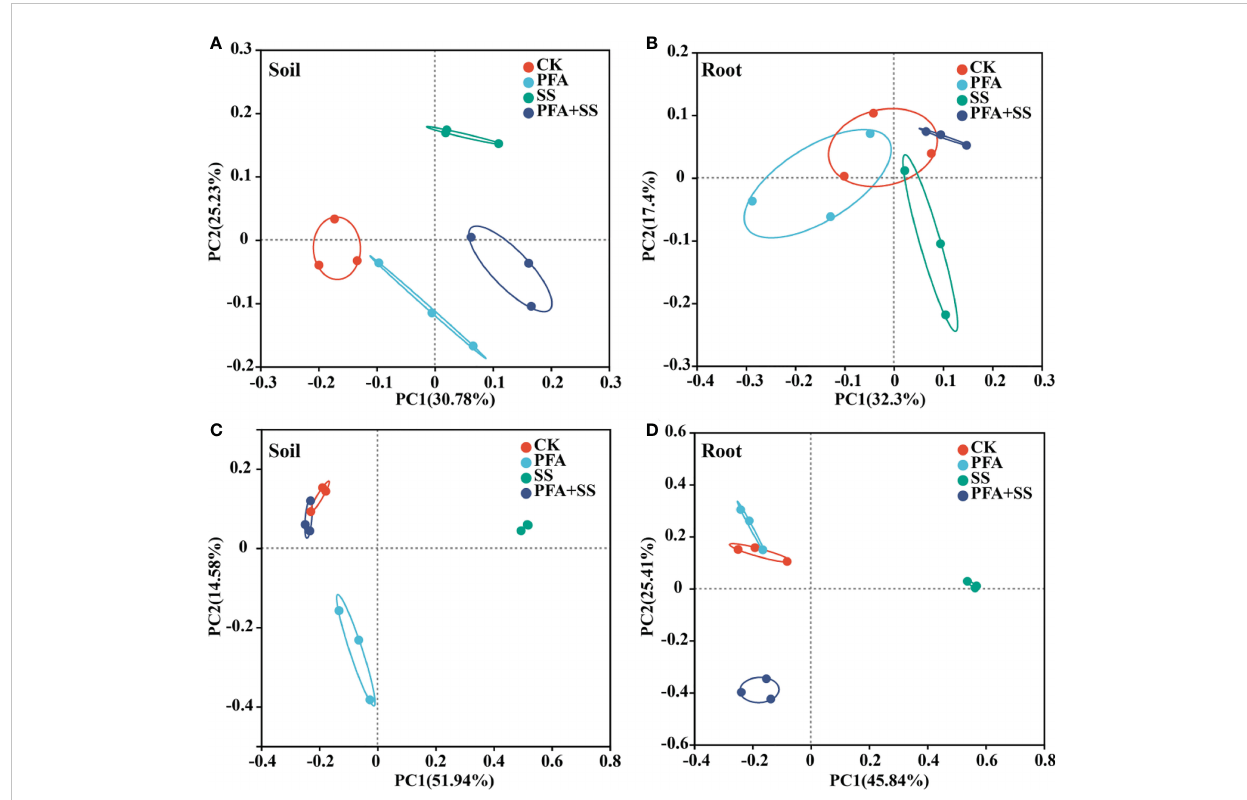
FIGURE 4 Principal components analysis (PCoA) based on the microbial community of the seedlings at the OTU level. (A) Bacterial community for the rhizosphere soil sample; (B) bacterial community for the root sample; (C) fungal community for the rhizosphere soil sample; (D) fungal community for the root sample. CK, the seedlings without PFA and salt stress; PFA, the seedlings amended with PFA and without salt stress; SS, the seedlings with salt stress; PFA+SS, the seedlings amended with both PFA and salt